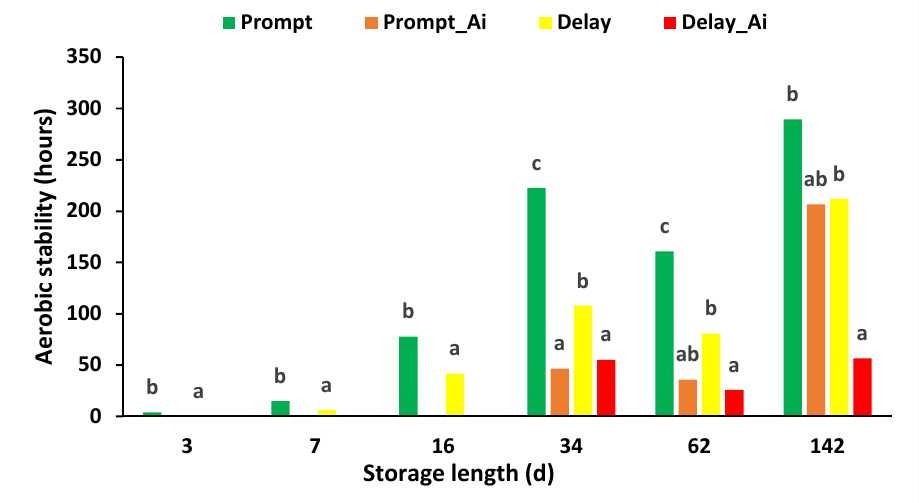
Figure 2. Relationship between the counts of total and lactate-assimilating yeasts in maize silages. Despite differences between sealing time, aerobic stability (ASTA) was always below two days during the first week of storage (Figure 3). Thereafter, ASTA increased in promptly sealed silages without air until the end of fermentation. Throughout storage, silage sealed with delay and repeated air ingress showed the lowest ASTA. A strong ex- ponential relationship was found between the count of LAY and ASTA (Figure 4, R 2 = 0.752, p < 0.001).